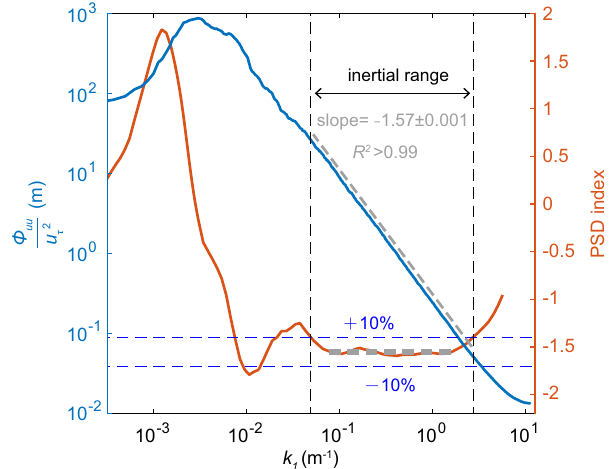
Fig. 1 | Example of determining the inertial range and the corresponding PSD scaling exponent. The data is the streamwise wind velocity at 12m height for the mildduststormdataset.ThePSDofthestreamwisevelocity(leftaxisandblueline) is smoothed using a 25% bandwidth moving fi lter 60 and divided by the squared friction velocity. The streamwise wavenumber k 1 is obtained from the frequency f usingTaylor ’ sfrozen fi eldhypothesis,i.e., k 1 =2 π f / U c ,where U c representsthemean convection velocity. The PSD index (right axis and orange line) is determined by a best- fi t method described in the main text. The horizontal dashed grey line marks theplateauofthePSDindex,whilethehorizontaldashedbluelinesmarktheregion that deviates from the plateau of the PSD index within±10%. The vertical dashed darklinesmarkthecorrespondinginertialwavenumberrange.Theobliquedashed greylinedenotesthebest- fi tlineintheidenti fi edinertialwavenumberrange,which is slightly shifted for clarity. The coef fi cient of determination R 2 is larger than 0.99 and the fi tted slope is − 1.57±0.001 (95% con fi dence